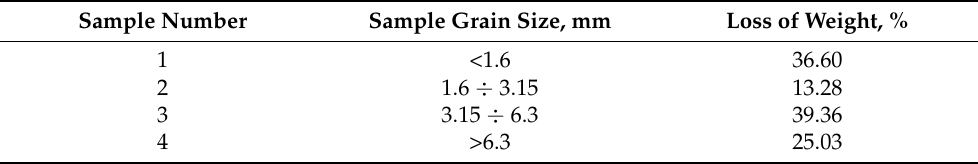
Figure 9. Mass in change of a sample with grain size > 6.3 mm during its heating. Table 4. Recorded weight losses of individual samples.